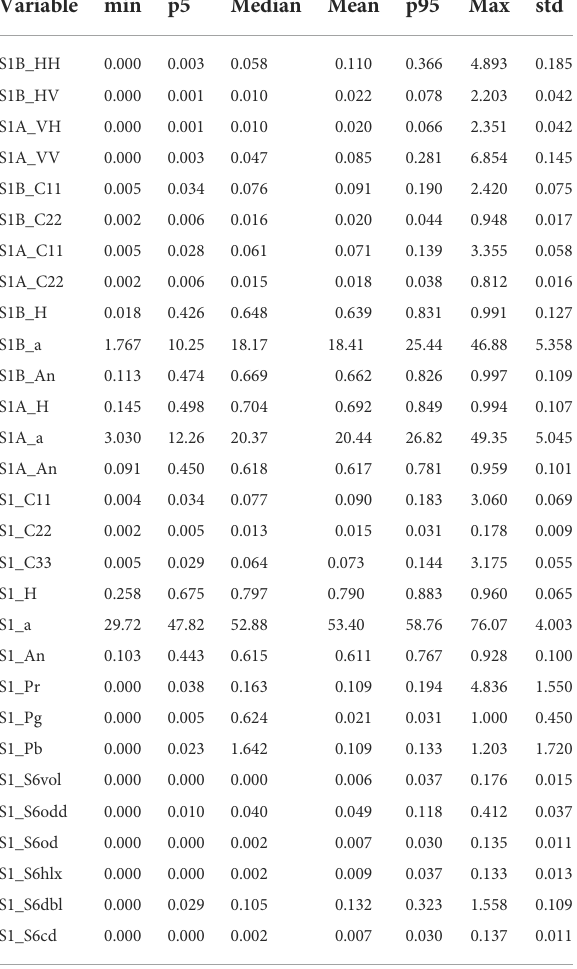
TABLE 3 Statistics of selected Sentinel-1 variables. Variable